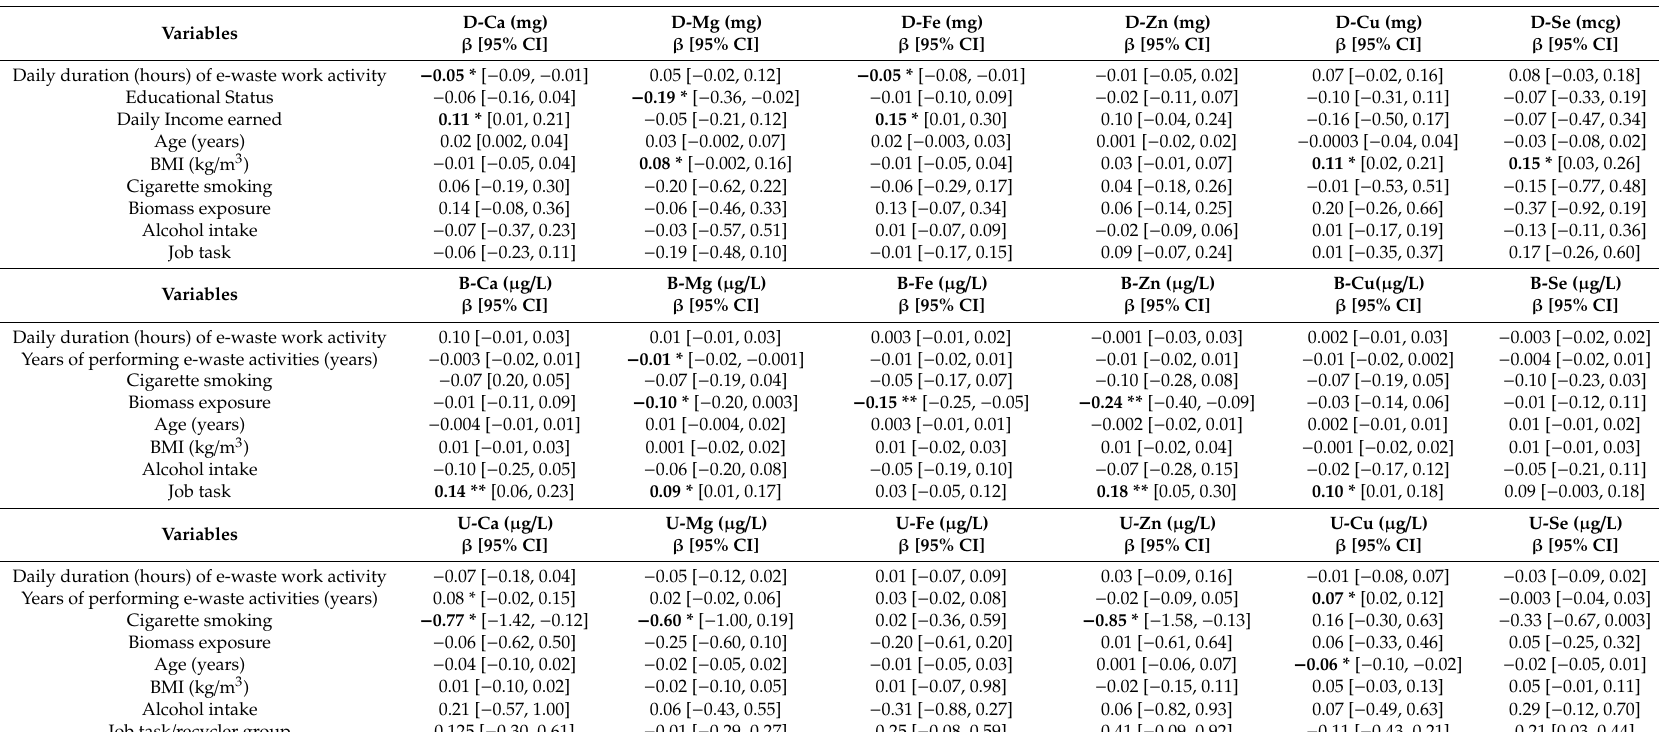
Table 5. Relationship of socio-demographic characteristics and job-related factors with dietary micronutrient intake (mg) and micronutrient levels in blood ( µ g / L) and urine ( µ g / L) of e-waste